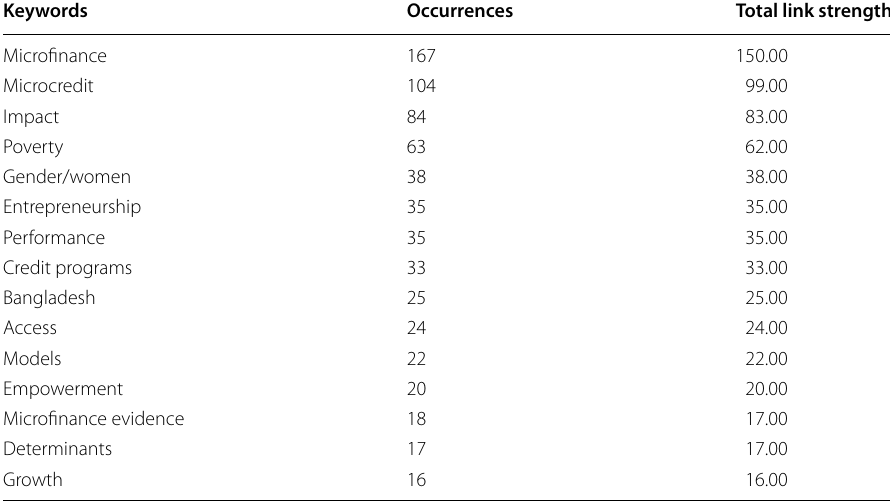
Table 11 Microfinance research trends based on the occurrence of the top 15 keywords in the 260 WoS indexed articles published between 1:2018 and 3:2021 according to the fractional counting